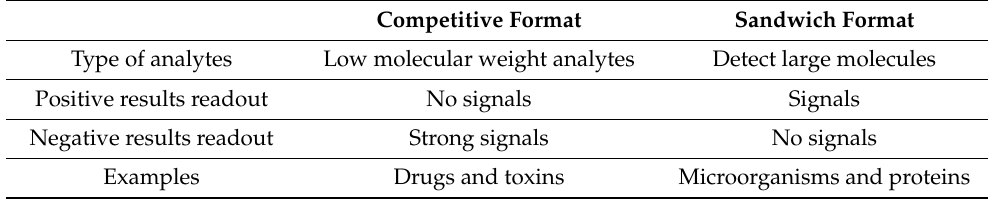
Table 2. Competitive versus sandwich